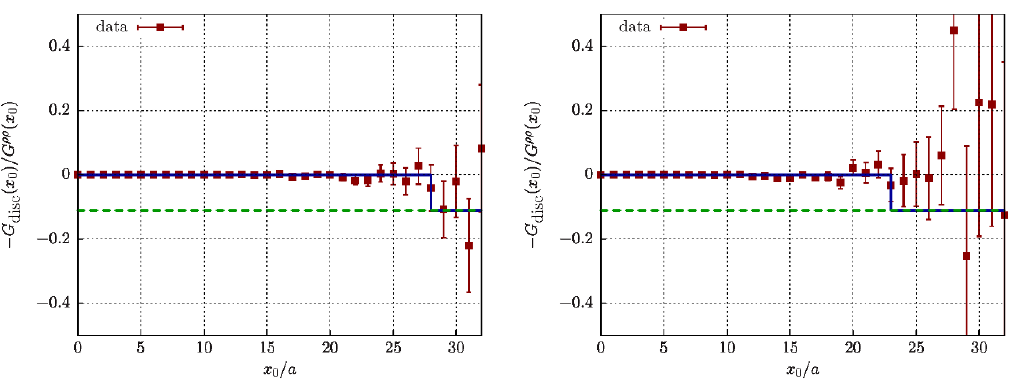
Figure 7 . The ratio of the disconnected to the (connected) iso-vector contribution to the vector correlator for ensembles E5 (left) and F6